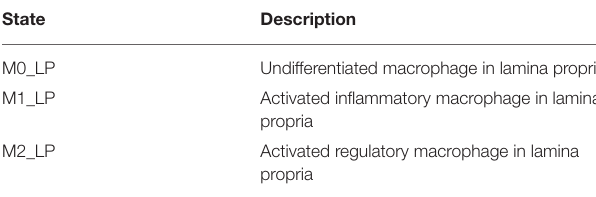
TABLE 3 | Simulation output variables of